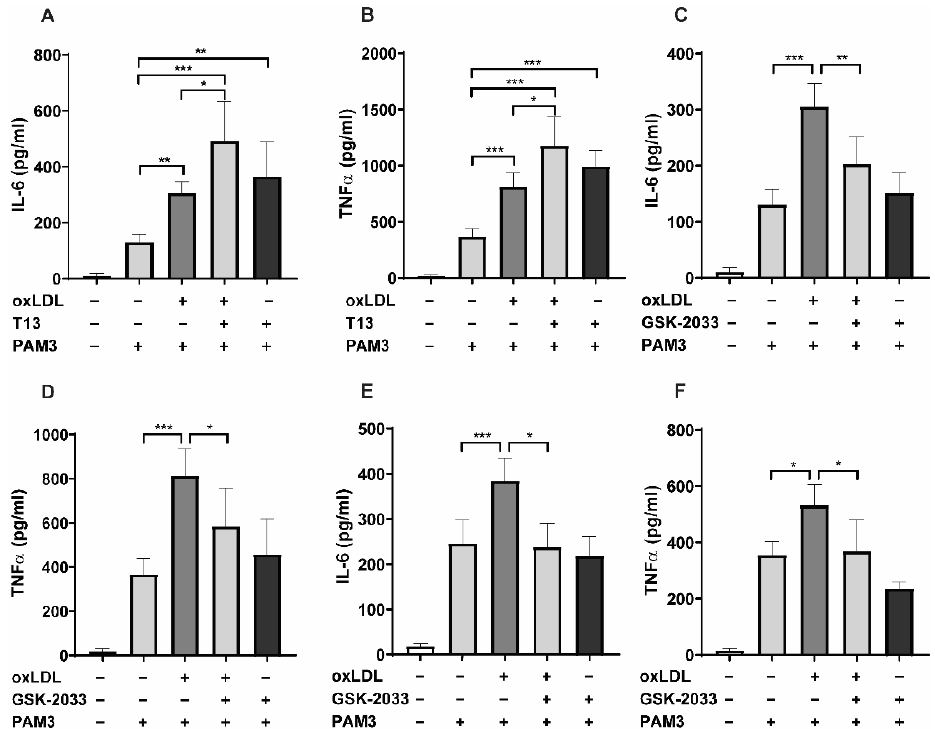
Figure 1. Liver X receptor (LXR) dependent regulation of the oxidized low-density lipoprotein (oxLDL)-induced proinflammatory phenotype in human monocytes. Monocytes were treated as indicated with 20 µg/mL oxLDL, 2 µM T1317 (LXR agonist), and 2.5 µM GSK2033 (LXR antagonist) or vehicle for 24 h, kept for 5 days in a complete medium, and restimulated with 5 µg/mL Pam3cys for 24 h. IL-6 ( A , C ) and TNFα ( B , D ) were measured in the supernatant. THP1 cells were differentiated to macrophages and were primed as described above; the cells were rested for 5 days and restimulated with 10 µg/mL Pam3cys for 24 h. IL-6 ( E ) and TNFα ( F ) were measured in the supernatant. Graphs represent mean values ± SD of six individuals in three different experiments. * p < 0.05, ** p < 0.01, and *** p < 0.001.